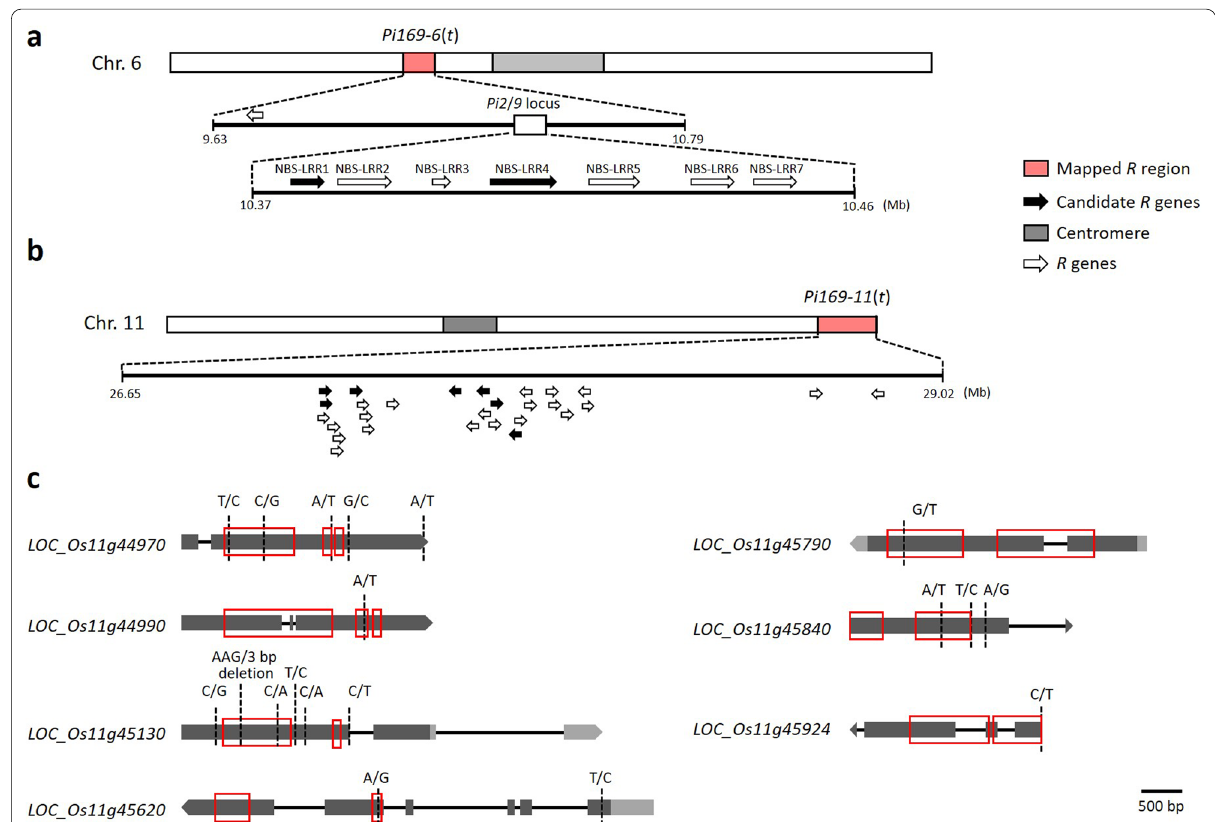
Fig. 2 Identification of candidate R genes in Pi169-6 ( t ) and Pi169-11 ( t ) in SA0169. a The R candidates identified in Pi169-6 ( t ) on chromosome 6. b The R candidates identified in Pi169-11 ( t ) on chromosome 11. Pink shaded region: the candidate region associated with rice blast resistance. Due to space limitation, the size of R genes was not scaled. c The sequence analysis of 7 candidate R genes in Pi169-11 ( t ). Red boxes, the predicted functional domains